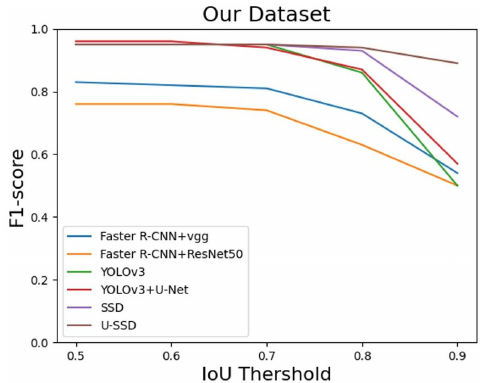
Figure 9. The F1-score from IoU = 0.5 to IoU = 0.9 on our dataset.